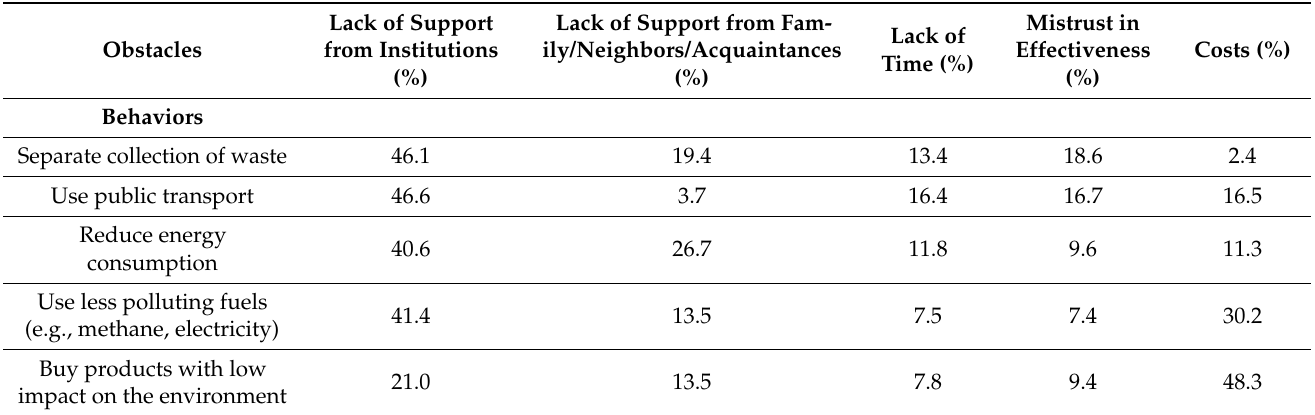
Figure 4. Frequency of the adoption of pro-environmental behaviors. Table 3. Perceived obstacles against pro-environmental behaviors (percentages of total respondents are reported for each statement. More than one obstacle may have been